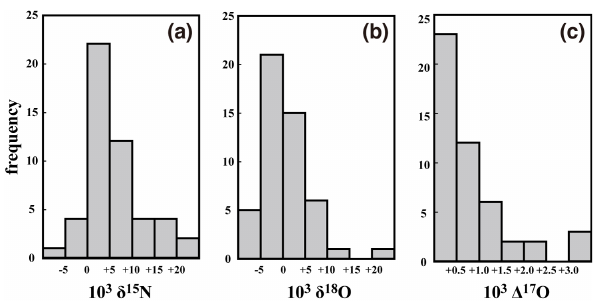
Fig. 2. Histograms of the δ 15 N (a) , δ 18 O (b) , and 1 17 O (c) of nitrate in the bottled mineral water samples. Those classified to the outside of each histogram were included in the nearby upper- most/lowermost